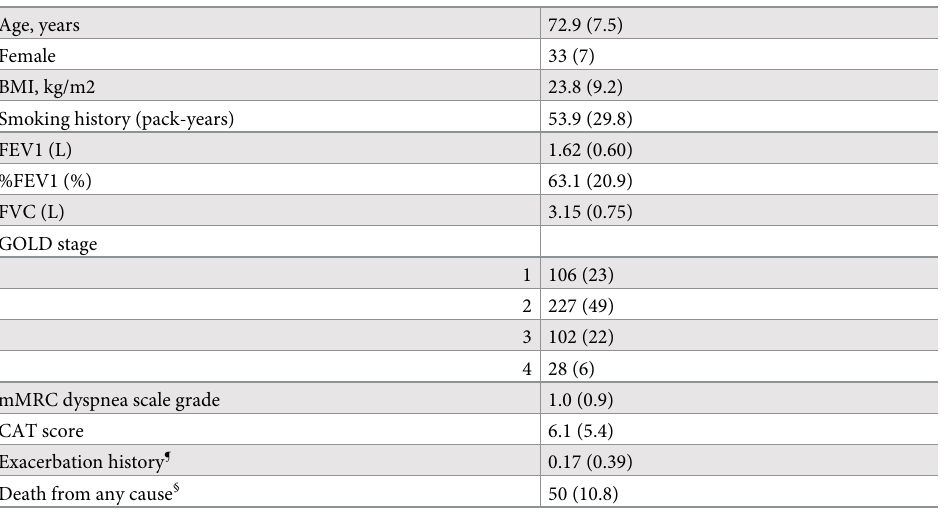
Table 1. Characteristics of the study patients (n =